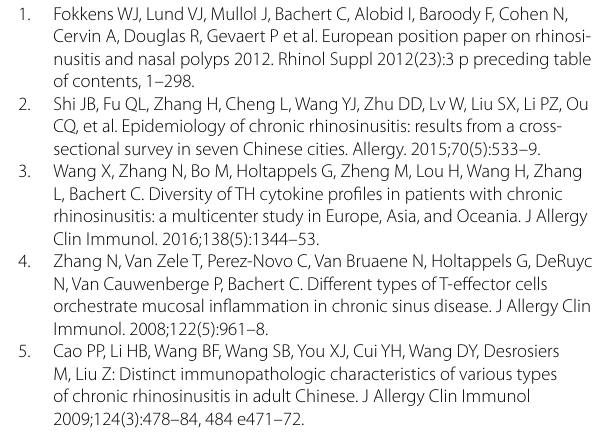
Additional file 1: Table S1. Antibodies used for flow cytometry. Table S2 . Primer sequences used for quantitative RT‑PCR. Table S3 . Cor‑ relations between DC surface phenotypes and cytokine mRNA expression levels in patients with NP (n 30). Table S4 . Correlations between DC = surface phenotypes and disease severity in patients with NP (n 30). = Table S5 . Total nasal symptom score. Abbreviations CRS: chronic rhinosinusitis; CRSwNP: chronic rhinosinusitis with nasal polyps; CRSsNP: chronic rhinosinusitis without nasal polyps; CT: computerized tomography; DCs: dendritic cells; IL: interleukin; IQR: interquartile range; mDCs: myeloid dendritic cells; MHC: major histocompatibility complex; qPCR: qualita‑ tive polymerase chain reaction; SD: standard deviation; TSLPR: thymic stromal lymphopoietin receptor; Th: T helper; TMCs: tissue mononuclear cells; TNSS: total nasal symptom